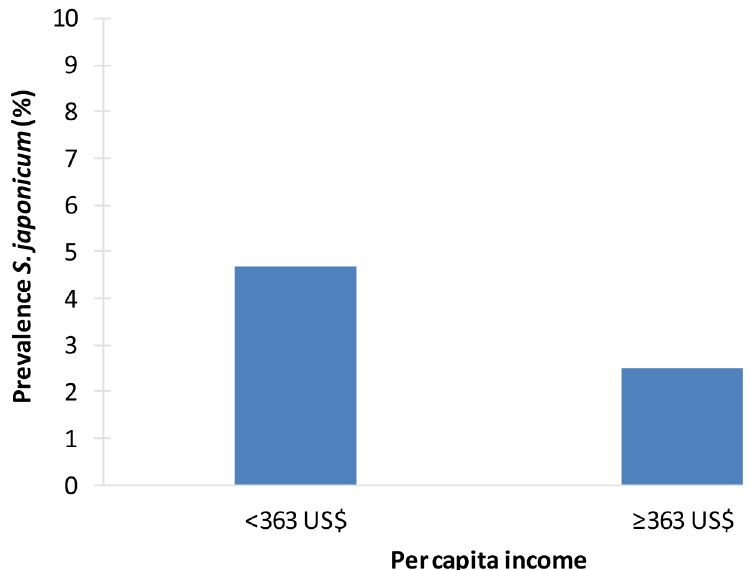
Fig 6. Example of socioeconomic inequalities in schistosomiasis: association between S . japonicum and income per capita at village level in Hunan province, China (2005) [28]. The studied villages represent four types of areas: lake-embankment, lake-beach, inside embankment, and hill areas. A total of 10,245 residents aged six years and older from 16 villages were included in the study. The presence of antibodies to S . japonicum was screened using the indirect hemagglutination (IHA) test, and stool samples were examined for IHA-positive cases. Per capita income was measured at the village level (currency rate used: 1 Yuan = US$0.121, July 2005). The overall infection prevalence was 4.1%. Infection prevalence was higher in poorer villages, ( p < 0.001).